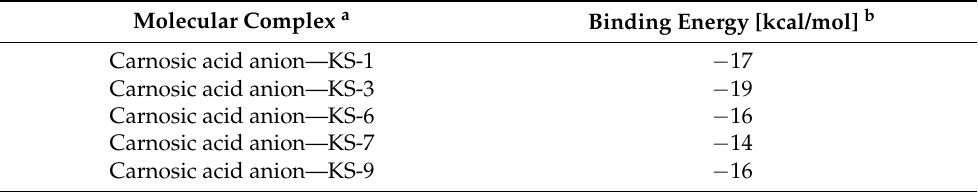
Figure 6. Cooperative activity of KS-3 and KS-6 with CA depends on the C7–C8 carbon-carbon double bond of the α , β unsaturated carbonyl moiety. ( a ) Molecular structures of KS-3, methyl 3-(4-hydroxyphenyl) propionate (MHP), methyl 4-hydroxybenzoate (MHB), KS-6, methyl 3-(3-hydroxy-4-methoxyphenyl) propanoate (MHMP) and methyl 3-hydroxy- 4-methoxy-benzoate (MHMB). KG-1a cells were cultured with the indicated phenolic compounds at 5 µ M, carnosic acid (CA) at 10 µ M, or their combinations, followed by the Trypan Blue exclusion assay (72 h; ( b , c )) or the annexin V/7-AAD binding assay (8 h; ( d )). ( b , c ) Effects of the indicated compounds on the number of viable cells ( b ) and the percent of cell death ( c ) in KG-1a cell cultures. ( d ) The extent of apoptosis (early + late) was determined by flow cytometry, and data are the means ± SD ( n = 5). #, p < 0.05, effect of a combination vs. sum of the effects of single agents; Student’s t test. Table 1. Binding energy of selected carnosic acid anion-hydroxycinnamic acid derivative molecular